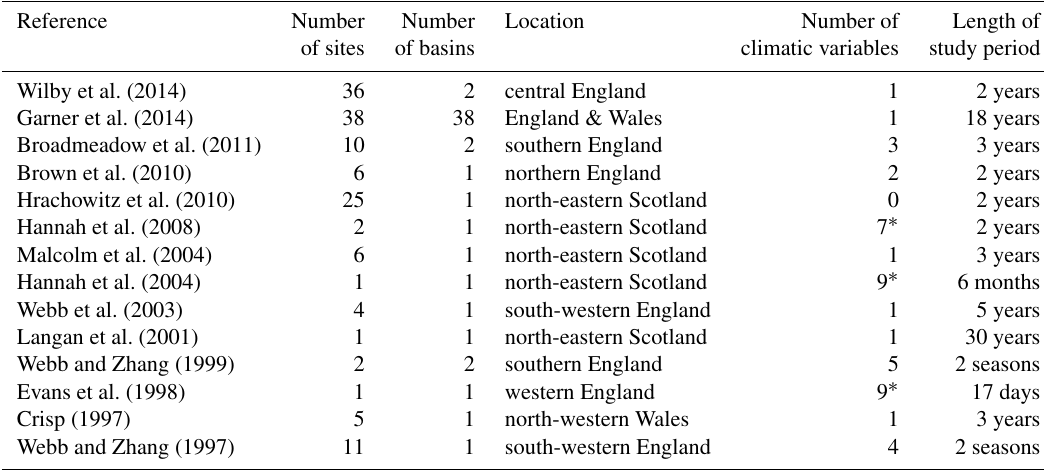
Webb and Zhang (1999) Evans et al.